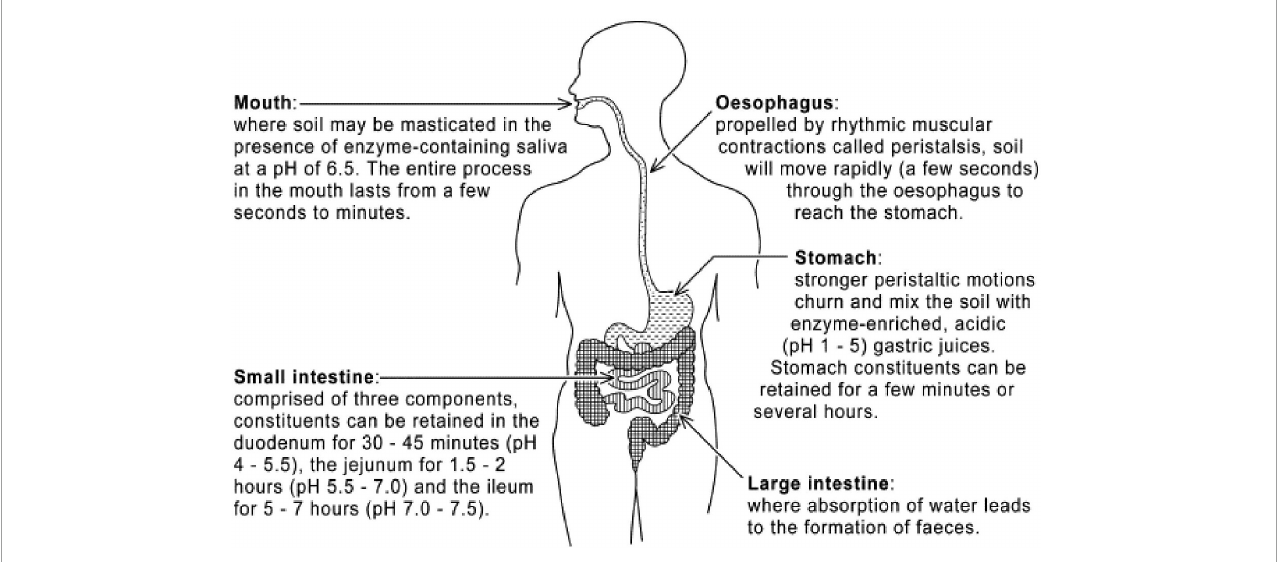
FIGURE5 The human digestion system: Conversion of soil into absorbable substances in the gastrointestinal tract starts in the mouth and continues in the stomach and intestines. Source: Abrahams (91).